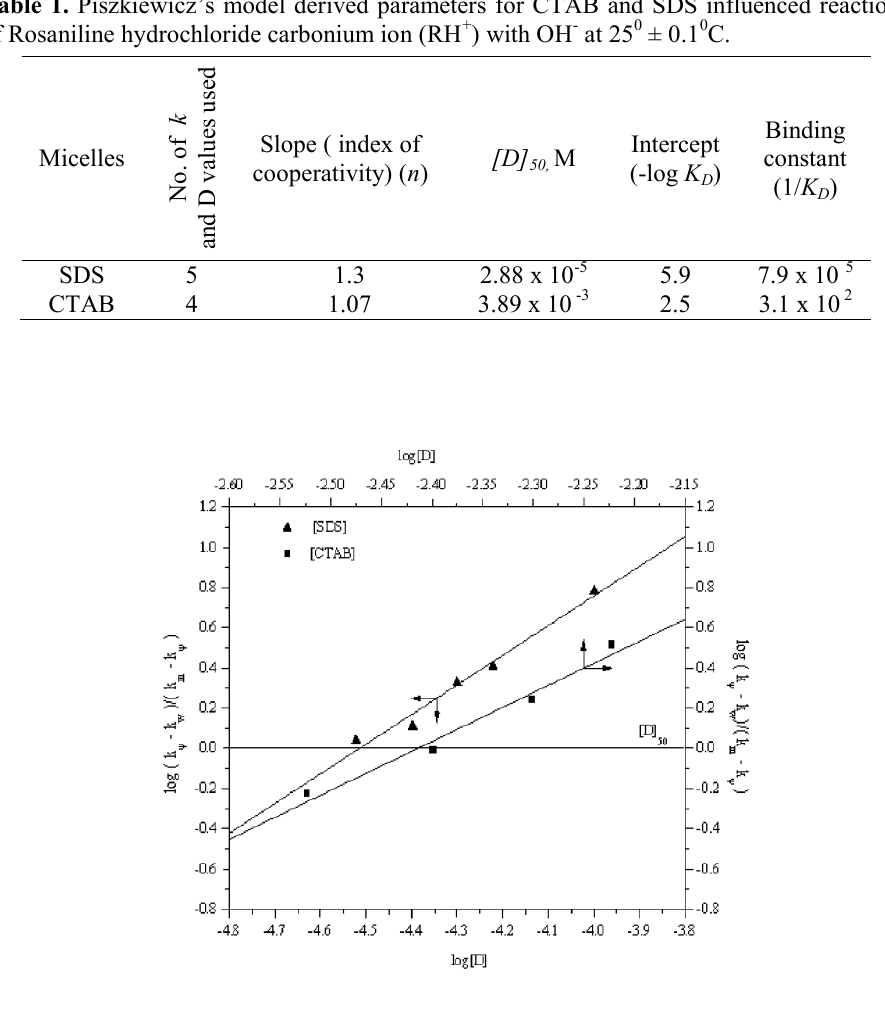
Figure 3 . Quantitative treatment of the effect of surfactants CTAB and SDS on the reaction of RH + with OH - , applying Positive Cooperativity Model of Enzyme catalysis (Hill type